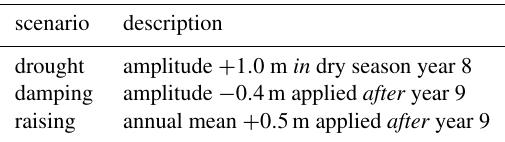
Table 2. Scenarios for the perturbation applied to the reference ground water table